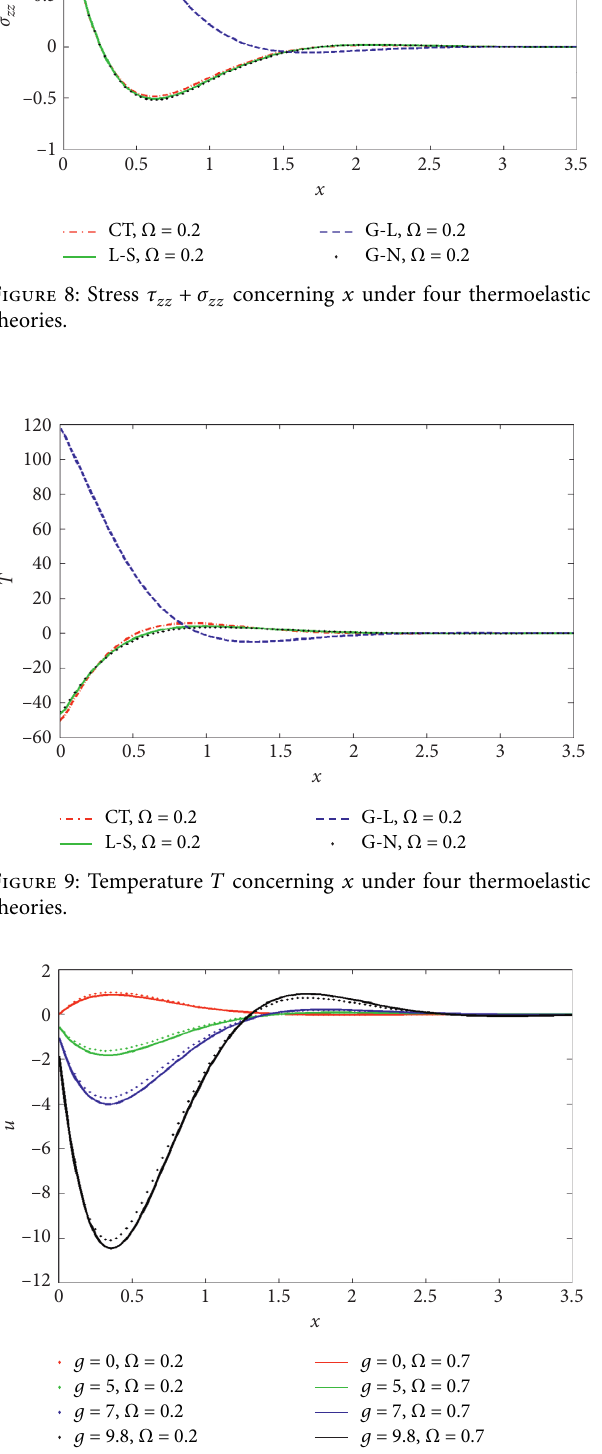
Figure 7: Stress τ x under four thermoelastic zz concerning theories.